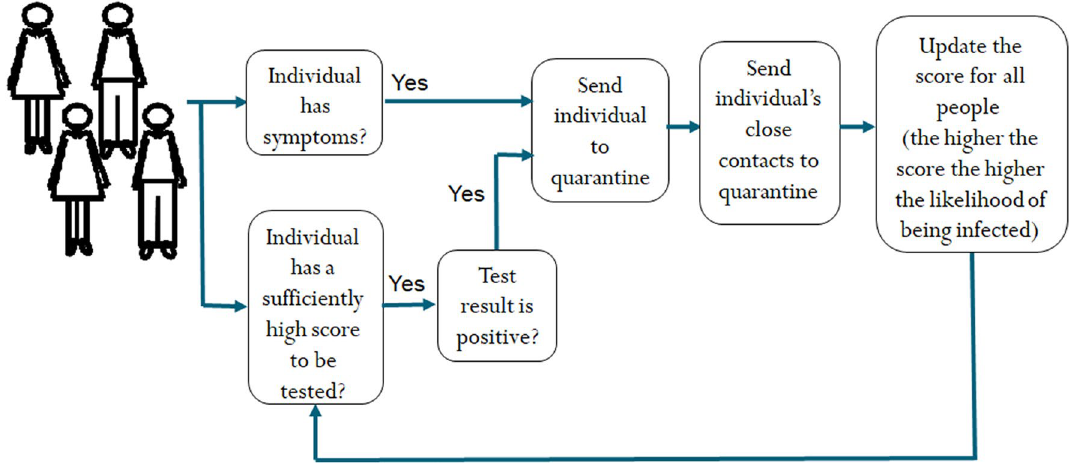
Figure 1. An illustration of the ATI algorithm proposed in this